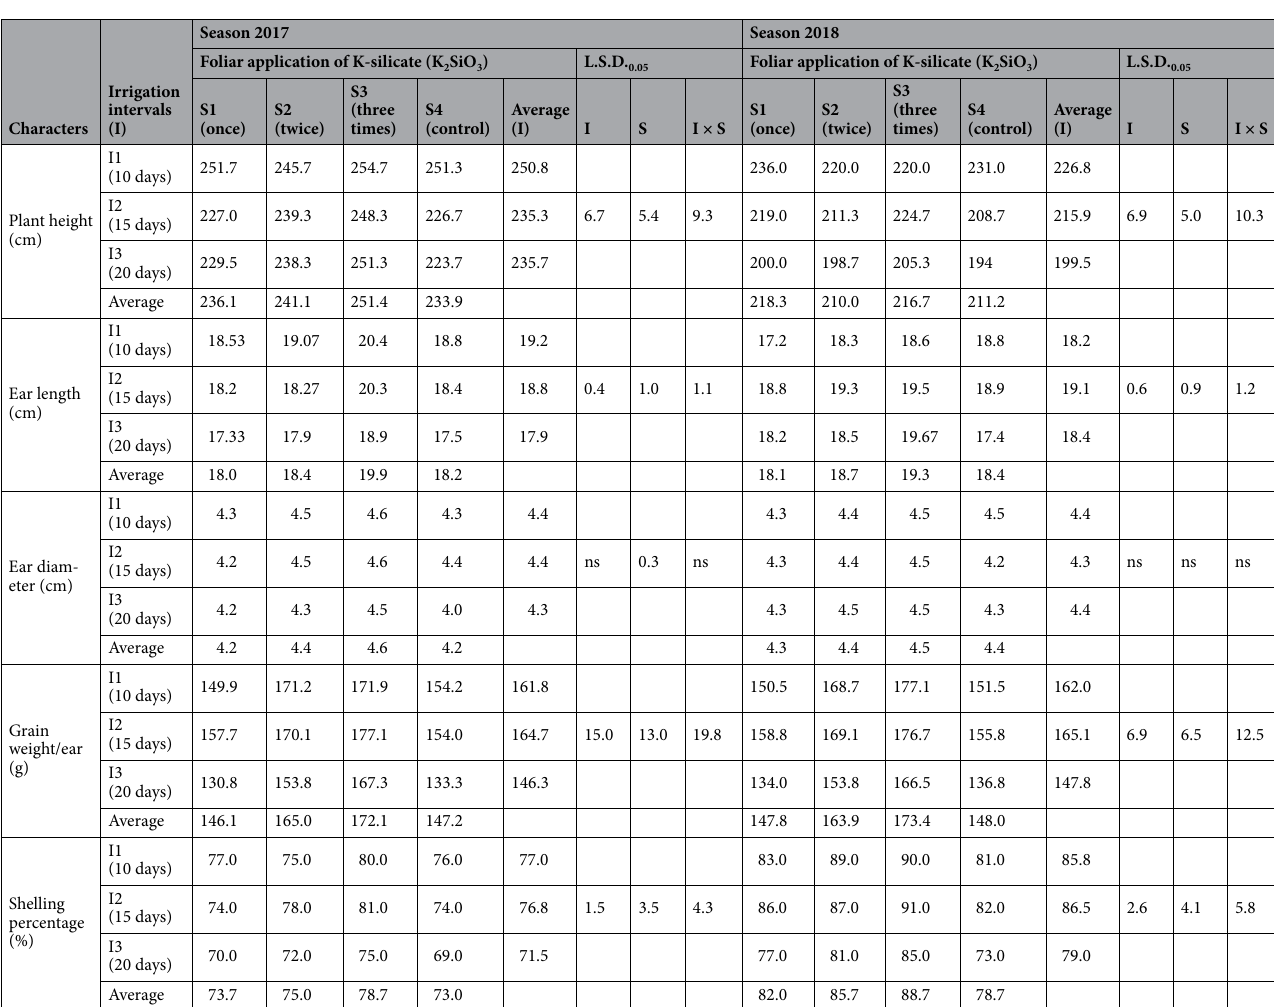
Table 2. Plant height, ear length, ear diameter, grain weight/ear, and shelling percentage of maize as affected by irrigation intervals and foliar application of K-silicates in the 2017 and 2018 seasons. I1, I2, and I3: irrigation intervals treatments; S1,S2, S3 and S4: foliar application of K-silicate treatments; ns, not significant; L.S.D.at 5%, the least significant difference at a 5% level of